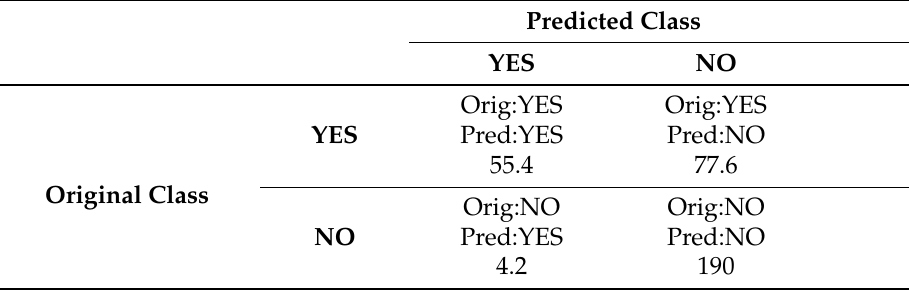
Table 2. Average confusion